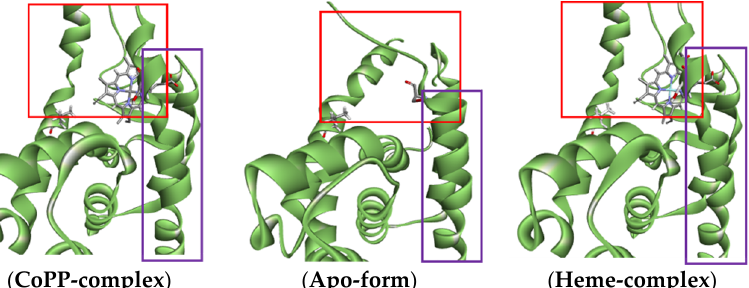
Figure 13. Visualization of the changes in conformation at the end of Helix 11 (purple box) that caused by the enlarged ligand-Agonist-REV-ERB β -LBD (red box). The visualization of REV-ERB apo-structured was shown as comparison and the NCoR structure was omitted to make clear im- age.